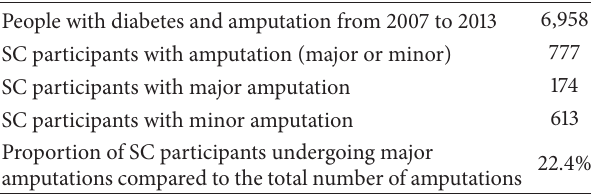
in networks (SC), with 22.4% of these undergoing major amputations (Table 1).